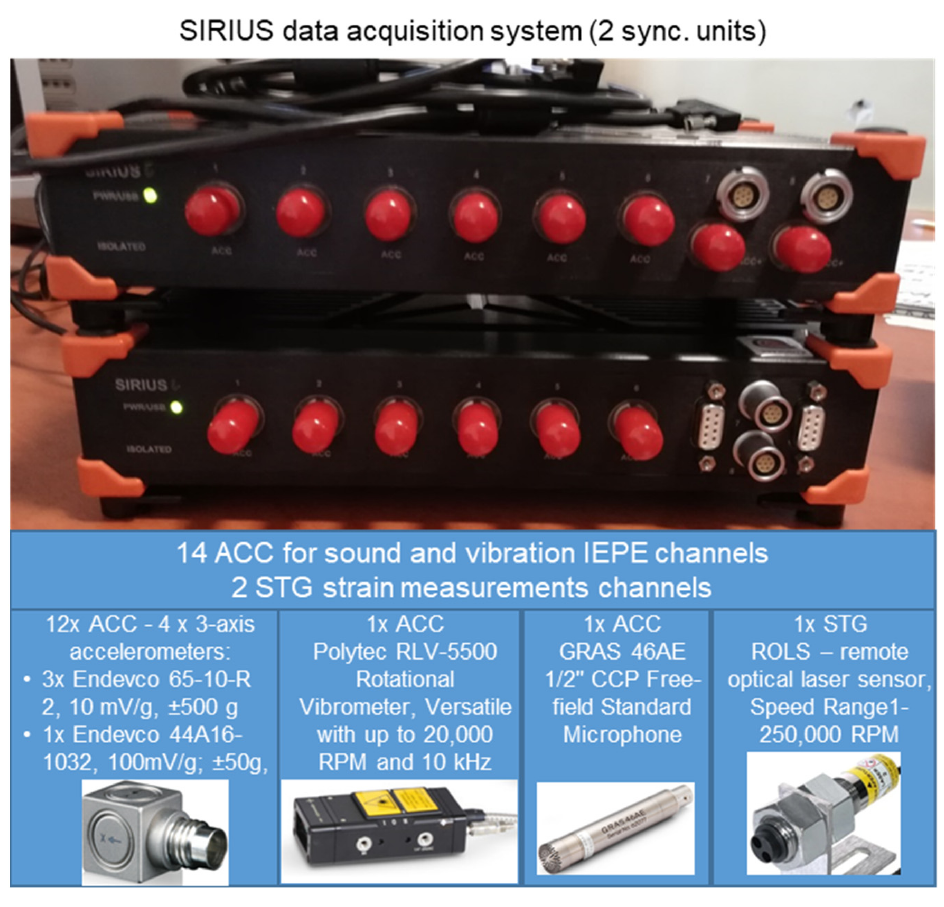
Figure 4. Measurement system with sensor specifications.